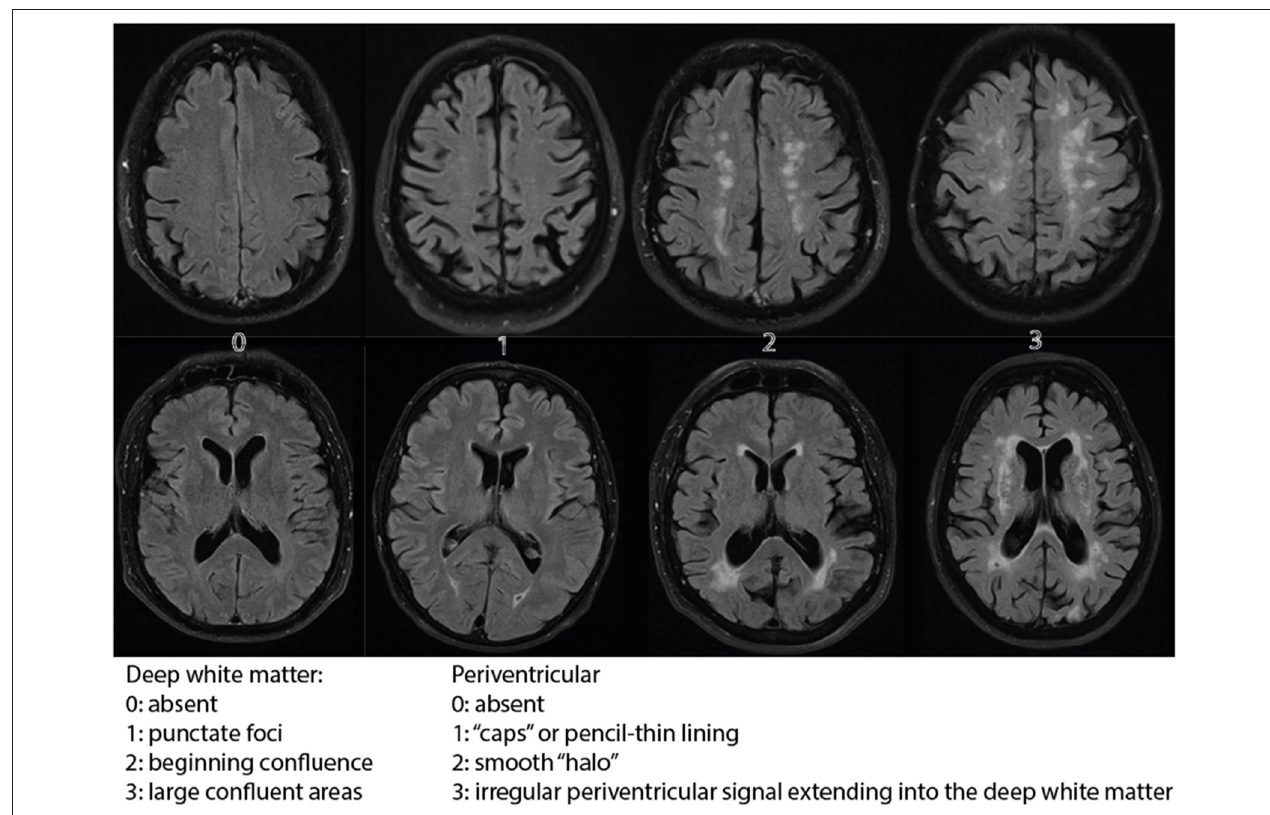
FIGURE 2 | Fazekas distribution. The distribution of the Fazekas scale score 1 up to 6 over the both cohorts displayed in percentages. VN, vestibular neuritis.